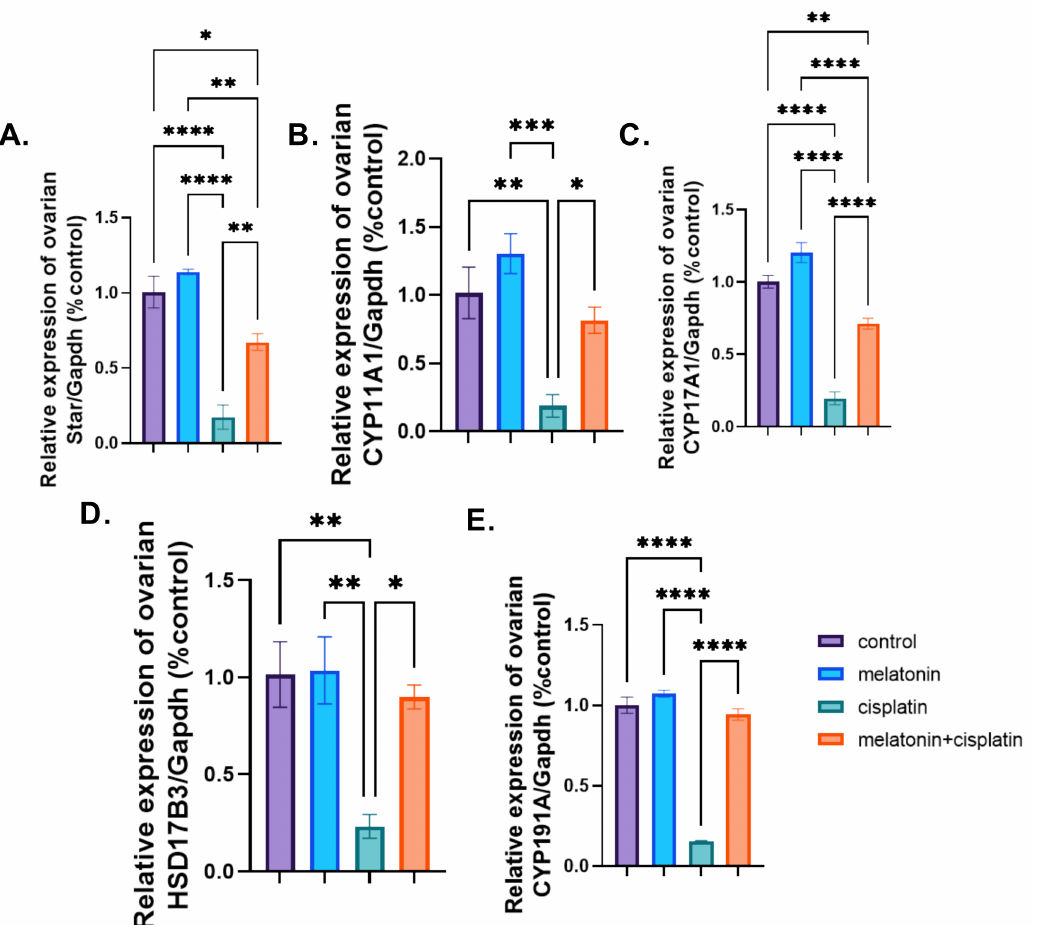
Figure 10. Effect of melatonin administration in cisplatin-induced ovarian impairment in fe- male rats on mRNA expression of ovarian Cyp19A1, Cyp17A1, Cyp11a1, HSD17B3, and STAR enzymes ( A – E ). ( A ). Ovarian Star/ Gapdh (% control), ( B ) ovarian Cyp11a1/ Gapdh (% control), ( C ) ovarian Cyp17A1/ Gapdh (% control), ( D ) ovarian HSD17B3/ Gapdh (% control), and ( E ) ovarian Cyp19A1/ Gapdh (% control). Data are expressed as means ± SEM. n = 8. *, **, ***, **** indicate significant difference ( p < 0.05, p < 0.01, p < 0.001, and p <